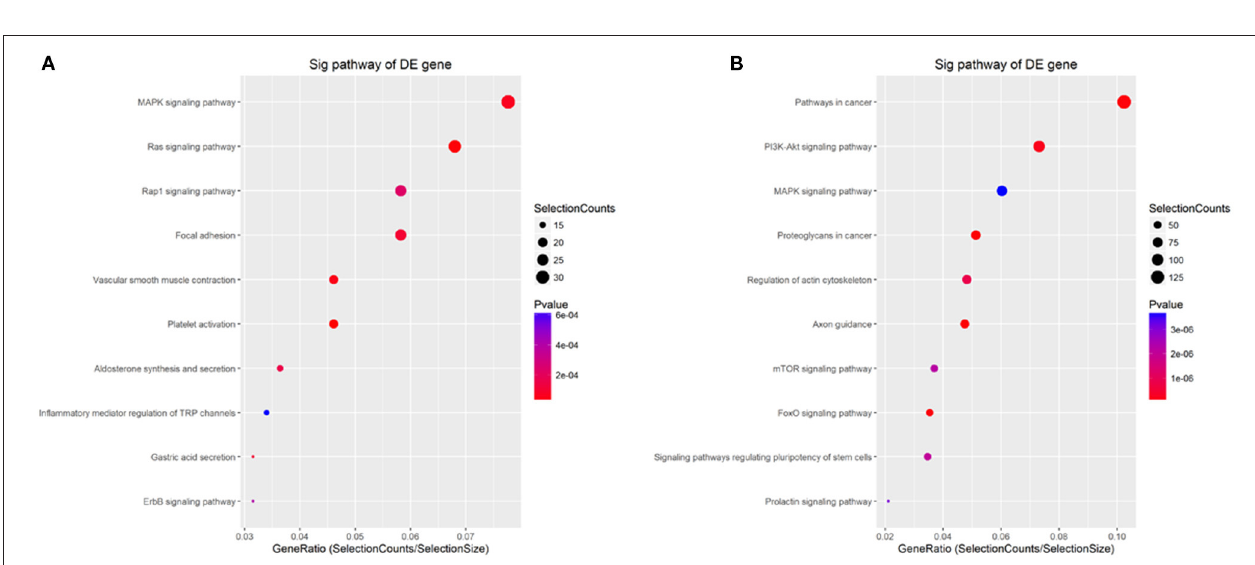
FIGURE 7 | KEGG analysis for the targets of common differentially expressed miRNAs. (A,B) KEGG analysis for the targets of up- and down-regulated common differentially expressed miRNAs, respectively. The p -value denotes the significance of the pathway correlated to the condition. The lower the p -value, the more significant is the pathway. The P -value cut-off is